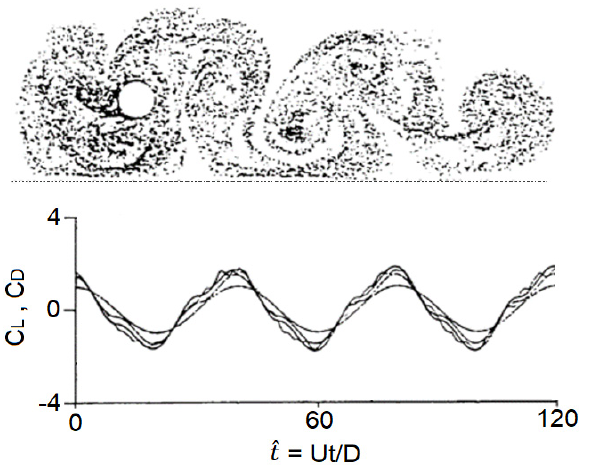
Figure 16. The flow pattern at t = 120, and the force coefficients for G/D = 2, Kc = 40 and Re = 25,000.